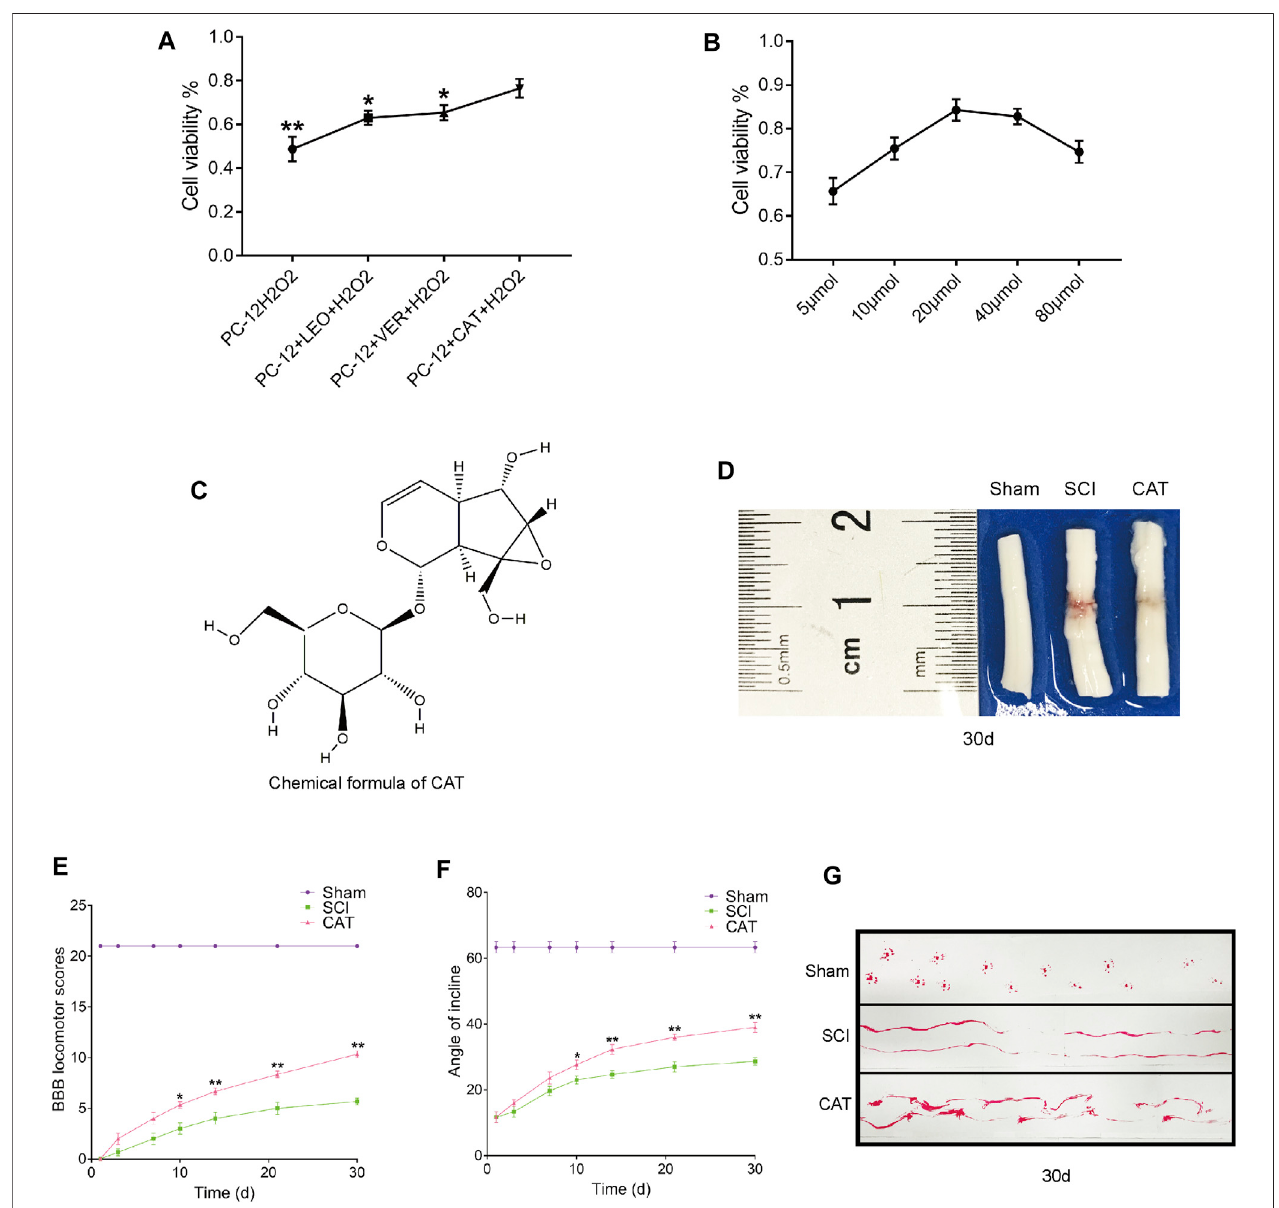
FIGURE 2 | Screening against the therapeutic components of RG and found that CAT promotes locomotor function recovery in SCI rats. (A) CCK8 experiments were used to examine cell survival after LEO-, VER-, and CAT-protected cells from hydrogen peroxide stimulation. “ * ” represents p < 0.05, “ ** ” represents p < 0.01 versus the PC-12 + CAT + H 2 O 2 group. (B) Survival after different concentrations ofCAT-protected cells in the face of hydrogen peroxidestimulation. (C) The chemical formula of CAT. (D) Spinal cord pictorial diagram. (E,F) The scores of BBB and the scores of the inclined plane by administration RG. (G) Gait imprint analysis. Student ’ s t test was used to analyze CCK8 experiments. A two-way analysis of variance (ANOVA) test was used to analyze BBB scores and inclined plane test scores, and then Dunnett ’ s post hoc test was used. “ * ” represents p < 0.05, “ ** ” represents p < 0.01 versus the SCI group with statistical signi fi cance. Data are represented as mean ± SD ( n =